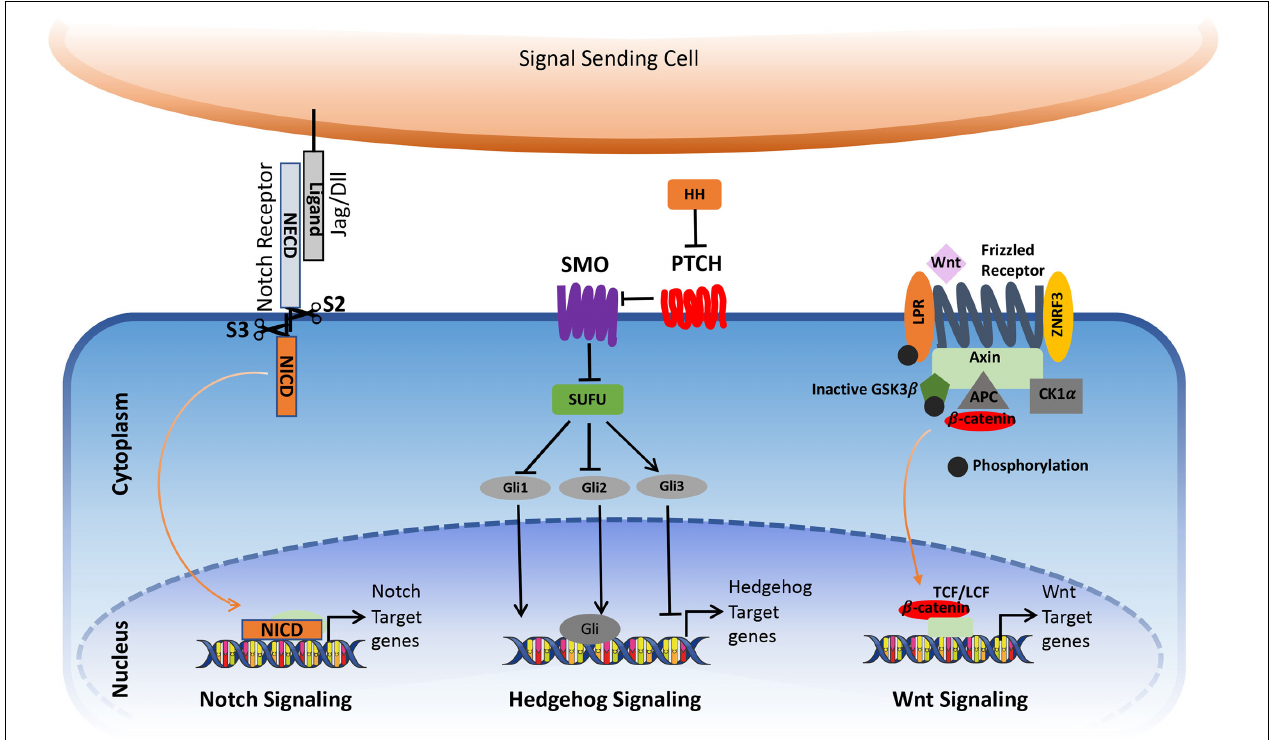
FIGURE 1 | Simplified view of canonical Notch, Hedgehog, and Wnt signaling pathway in cancer. The figure is widely discussed in the